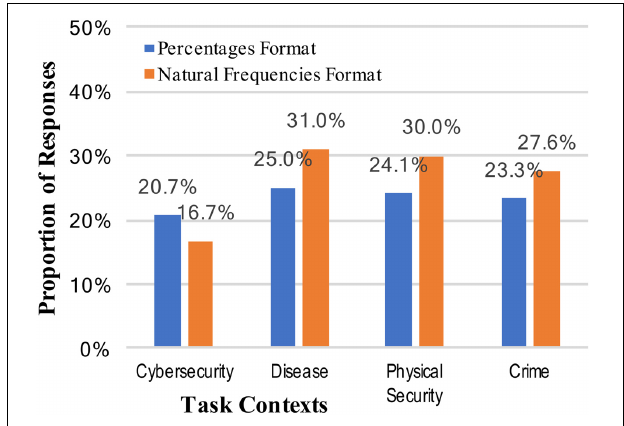
FIGURE 3 | Percentages of participants who reached the correct positive test rate (2 out of 100), across the context stories and numerical format